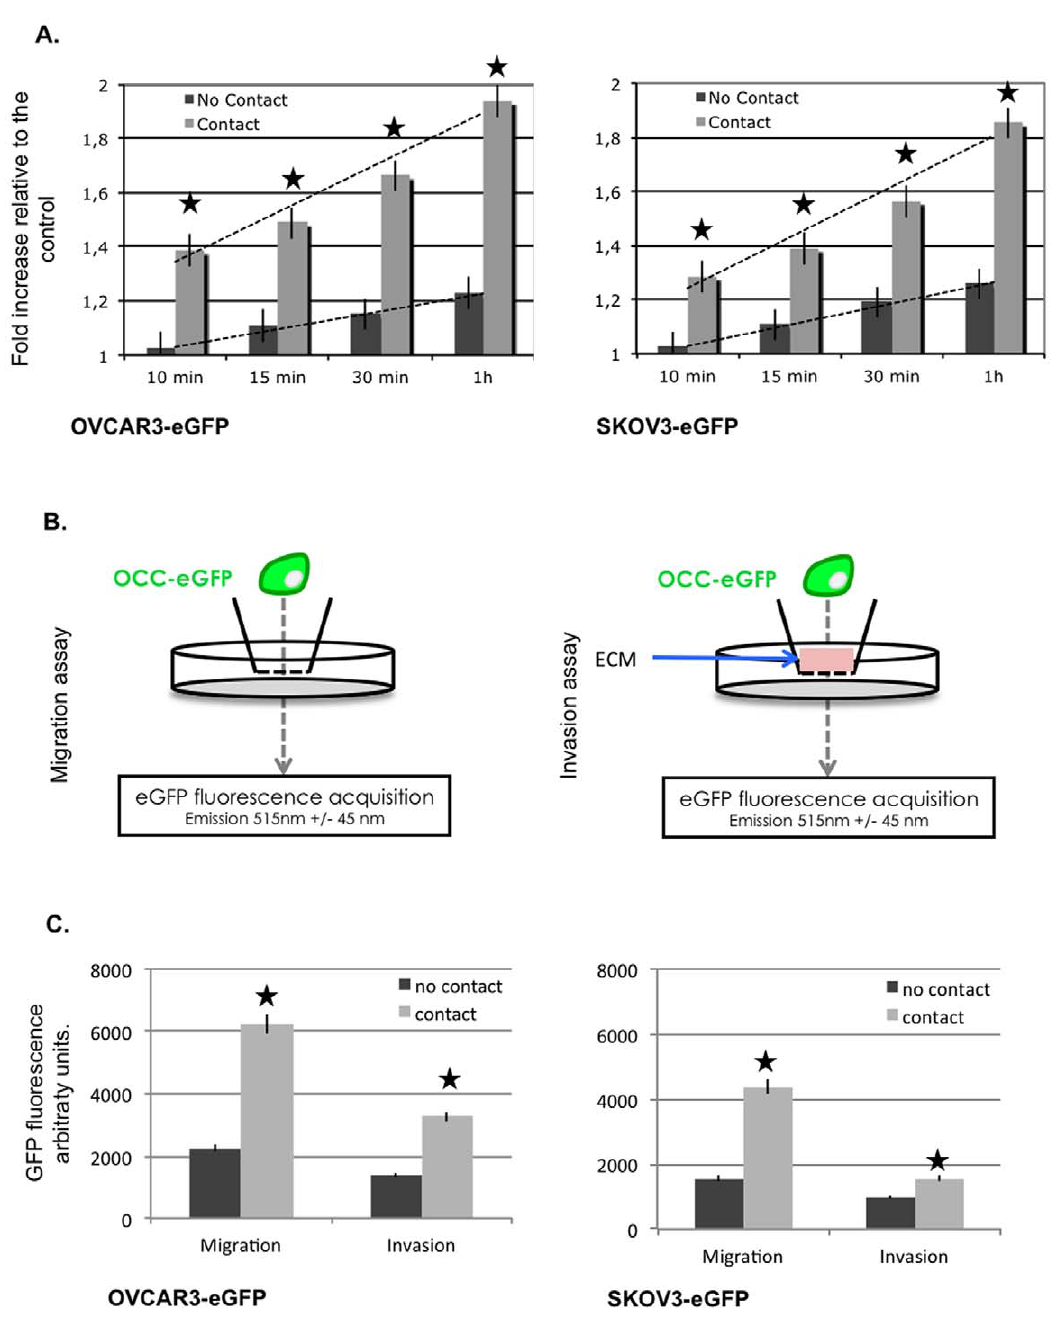
Figure 2. MCs increase OCC metastasis biological function: adherence, migration and invasion. A. OCC-eGFP (NIH:OVCAR3, left chart and SKOV3, right chart) were seeded on a Matrigel (BD Biosciences)-coated well for 10 min, 15 min, 30 min and 1 hour. Increased adherence to the ECM is observed when OCC were preemptively cultivated with MC (light grey bars) compared to the control (dark grey bars). B. Scheme representing the invasion and migration assay. C. Sorted OCC were seeded on (un) coated transwells and GFP signal of each well under the coated membrane was acquired after 24 h. Increased migration and invasion through the ECM is observed when OCC were preemptively cultivated with MC (light grey bars) compared to the control (dark grey bars). SEM are represented, n=3, | p , 0.05 t-Student Test.